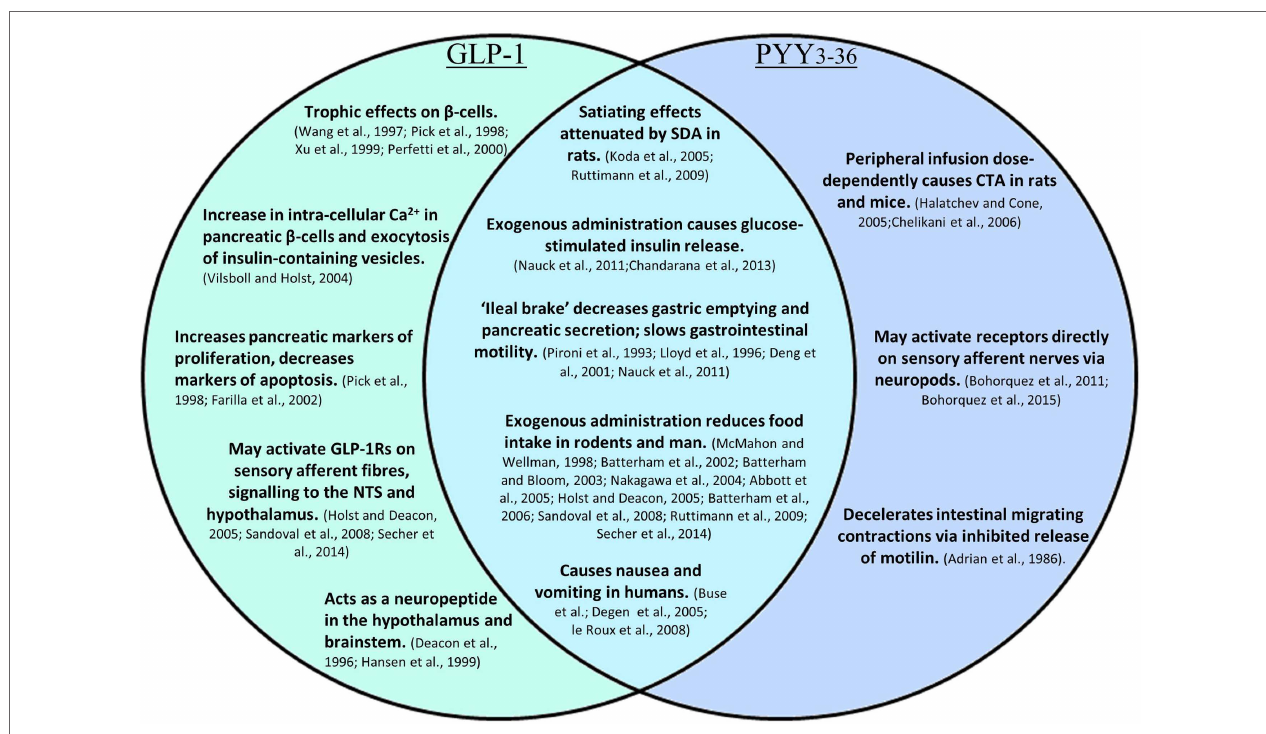
FiGURe 3 | A summary of the effects of GLP-1, PYY 3–36 , and the combined effects of both